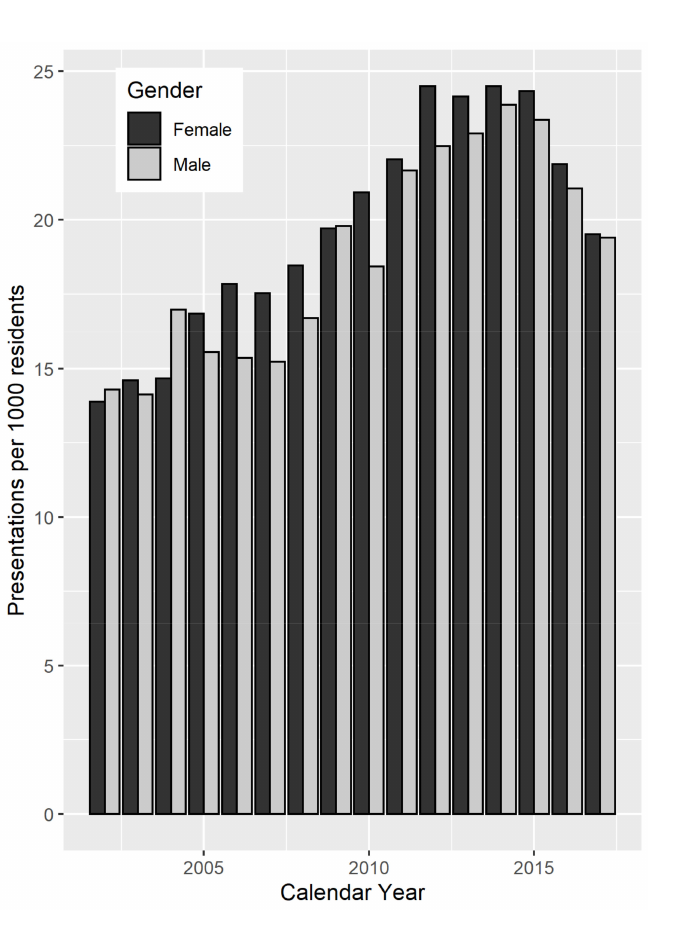
widely from 180 to 455 mm per calendar year, with a daily mean of 0.81 mm (SD 0.23). Mean daily summer rainfall (December–February) was 0.43 mm (SD 0.47), and mean daily winter rainfall (June–August) was 1.50 mm (SD